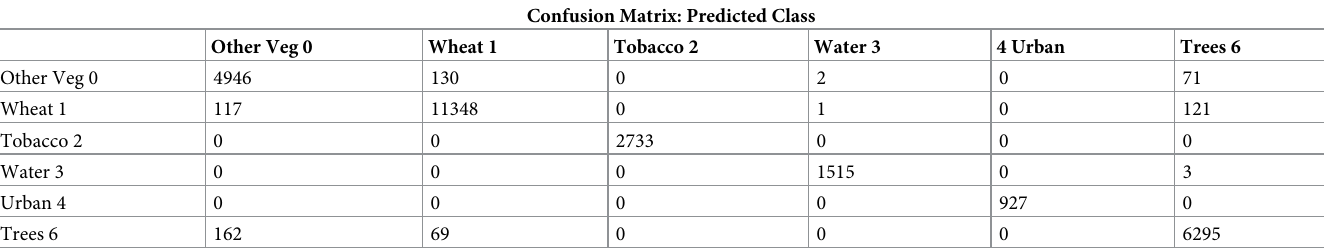
Table 7. Confusion matrix of ConvLSTM.